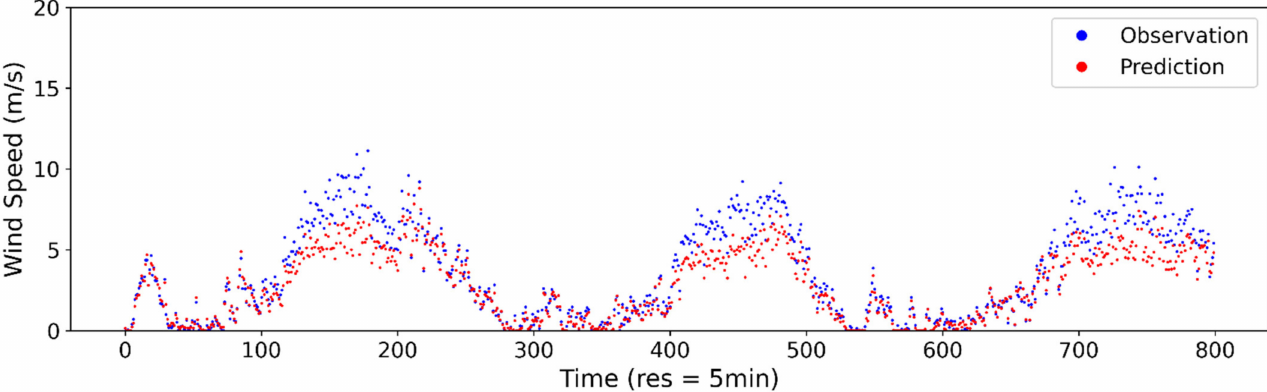
Figure A4. Estimated vs. observed wind speed at 5-min sampling interval using ANN